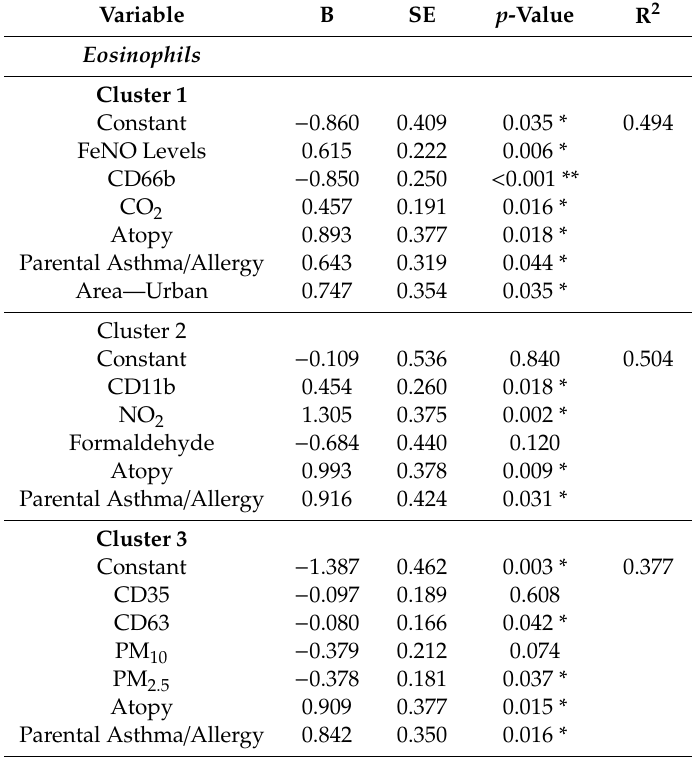
Table 4. Summary of the binary logistic regression models based on the clusters generated in the AHC analysis.